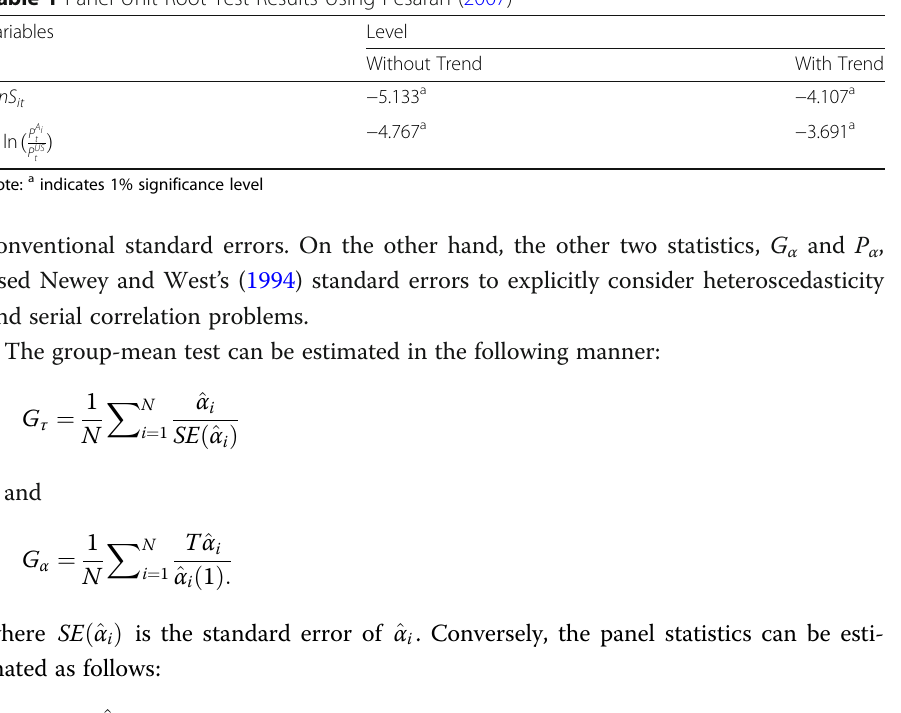
Table 1 Panel Unit Root Test Results Using Pesaran (2007) Variables Level dlnS it